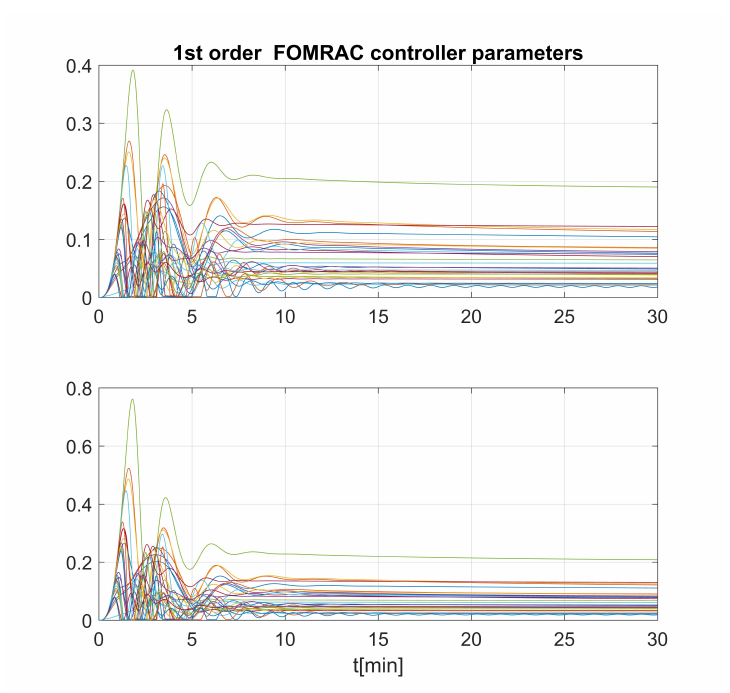
Figure 12. Controller parameters of the FOMRAC scheme using the 1st-order structure.